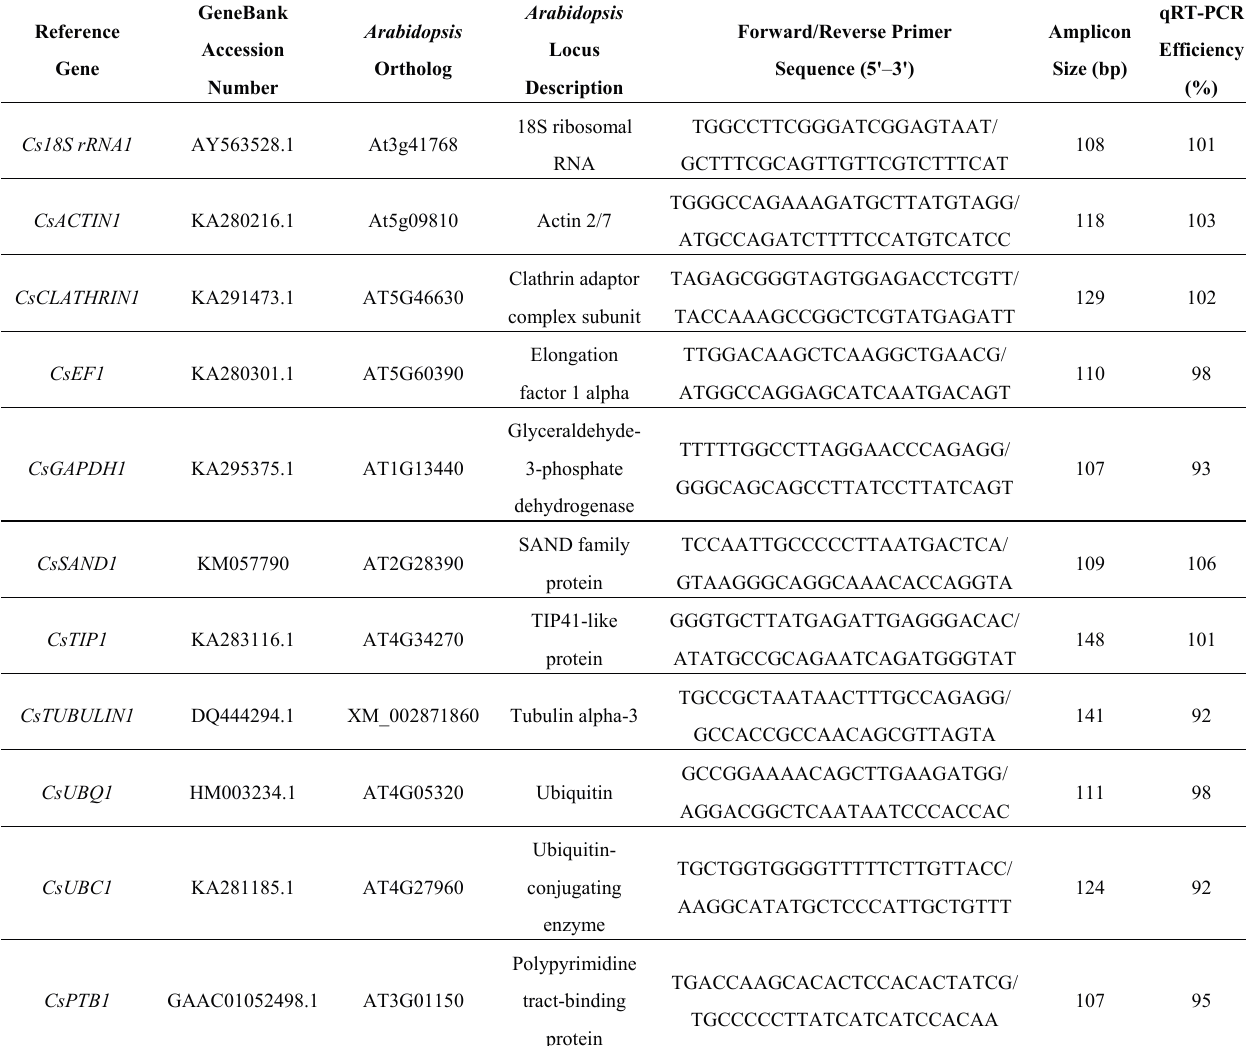
Table 1. Description of tea plant reference genes for